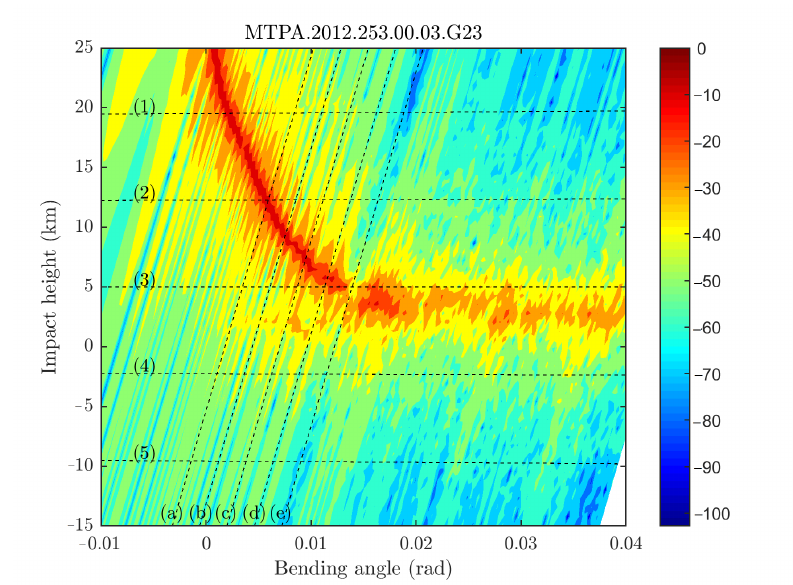
Figure 4. Occultation event from UTC 0003 2012-09-11, 20.16 ◦ S, 114.93 ◦ E. The dashed black lines show the various cross sections where we compare the amplitudes between STFT and SWPM.